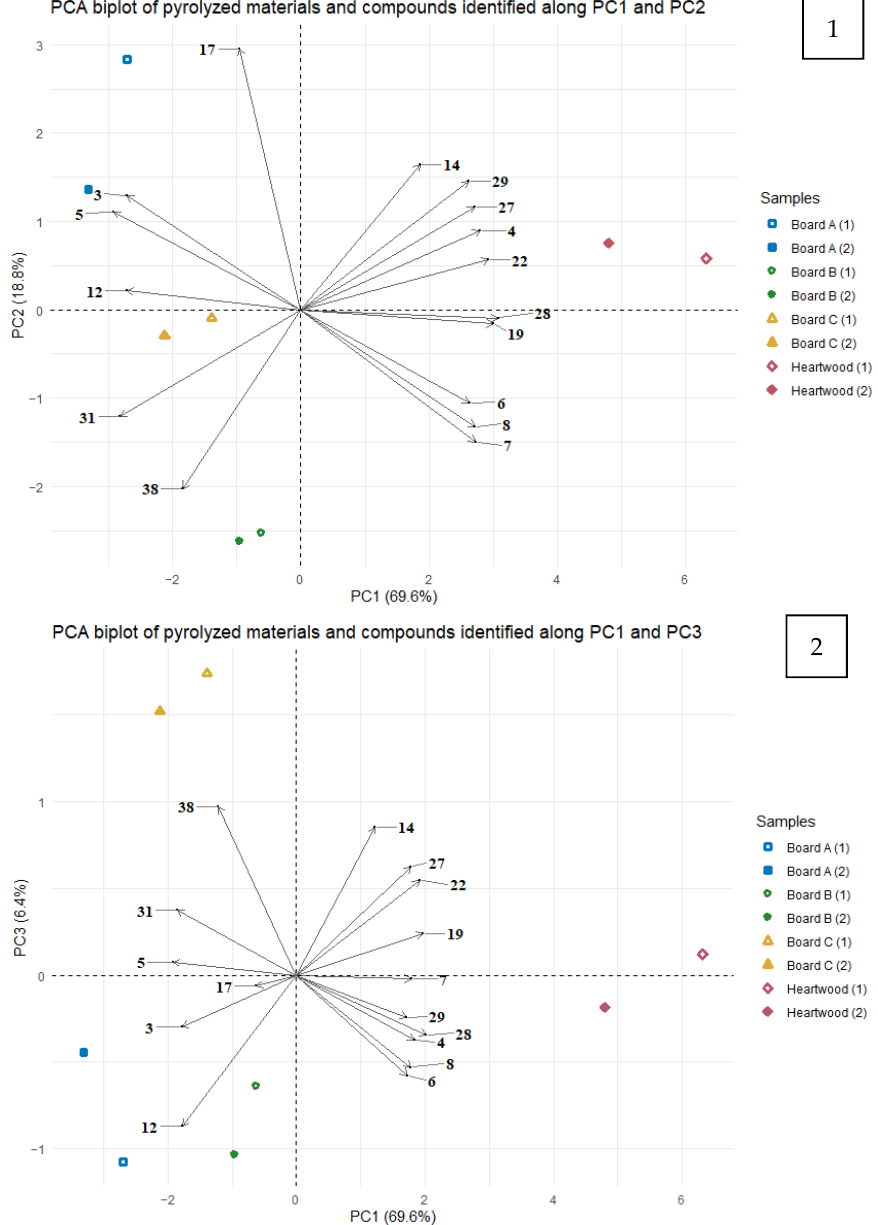
Figure 4. PCA biplot of individuals (samples) and variables (compounds identified by pyrolysis– GC-MS) along PC1 and PC2 dimensions ( 1 ) and along PC1 and PC3 dimensions ( 2 ). Variables are expressed with numbers corresponding to Table 3.